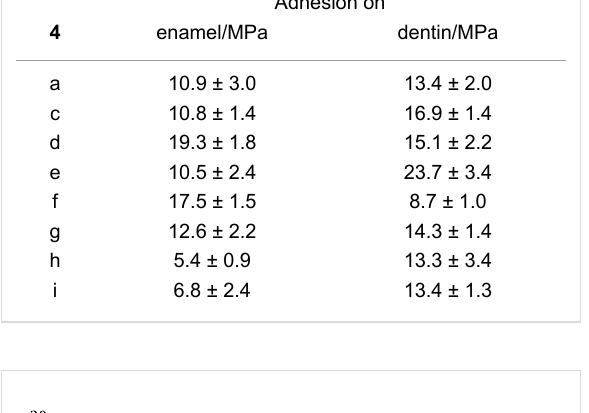
Table 3: Adhesion of an adhesive composition 4, comprising of poly- merizable acids 3, on enamel and dentin. Adhesion on